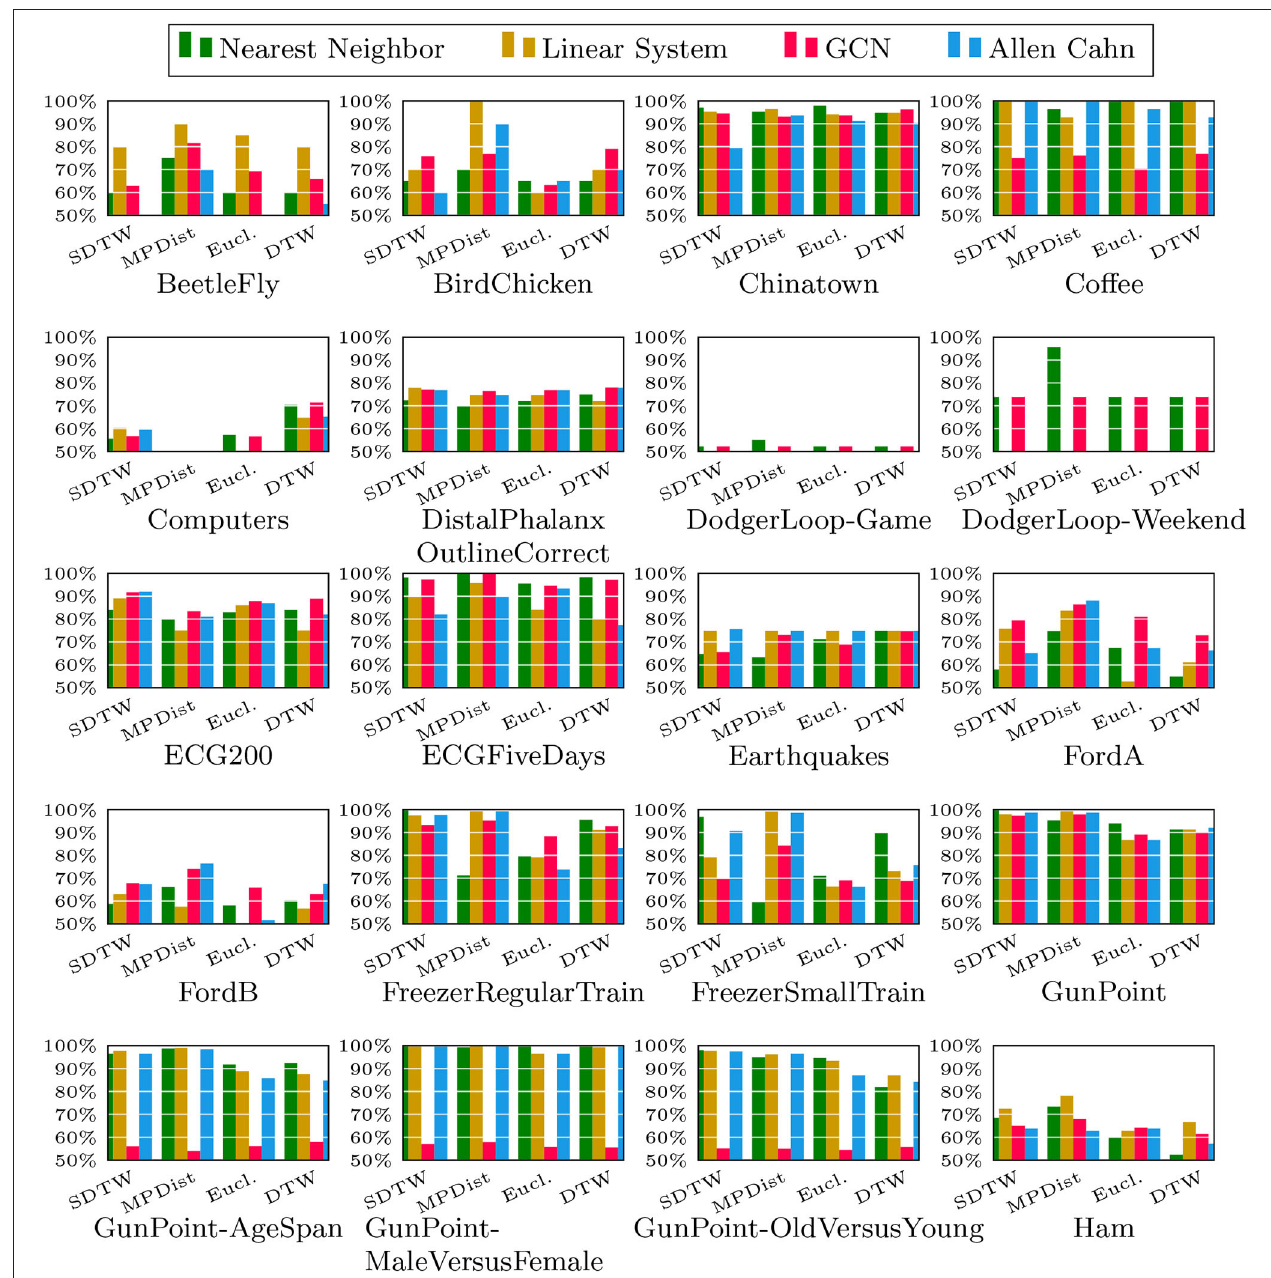
FIGURE 6 | Comparison of the proposed methods using various distance measures for a variety of time series data. The size of the training set is specified in TwoClassProblems.csv within http://www.timeseriesclassification.com/Downloads/Archives/Univariate2018_arff.zip.